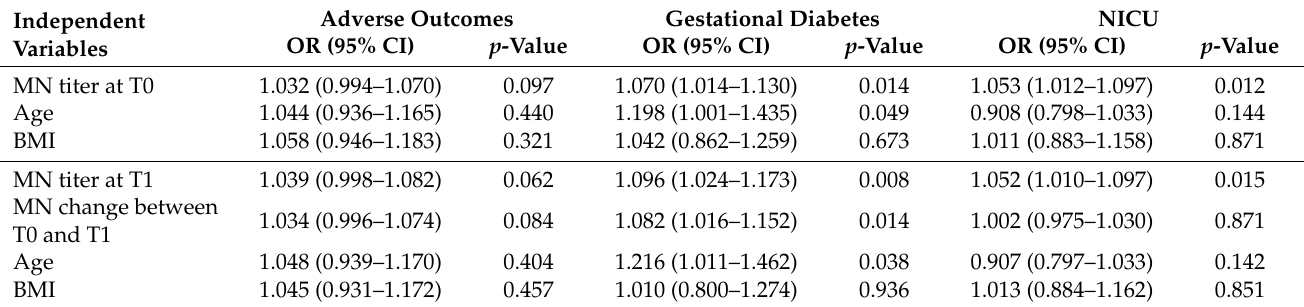
Table 7. Odds ratios (OR) of adverse outcomes, gestational diabetes, or need for NICU in associ- ation with MN titer at the first trimester of pregnancy (T0) and at peripartum (T1) after age and BMI